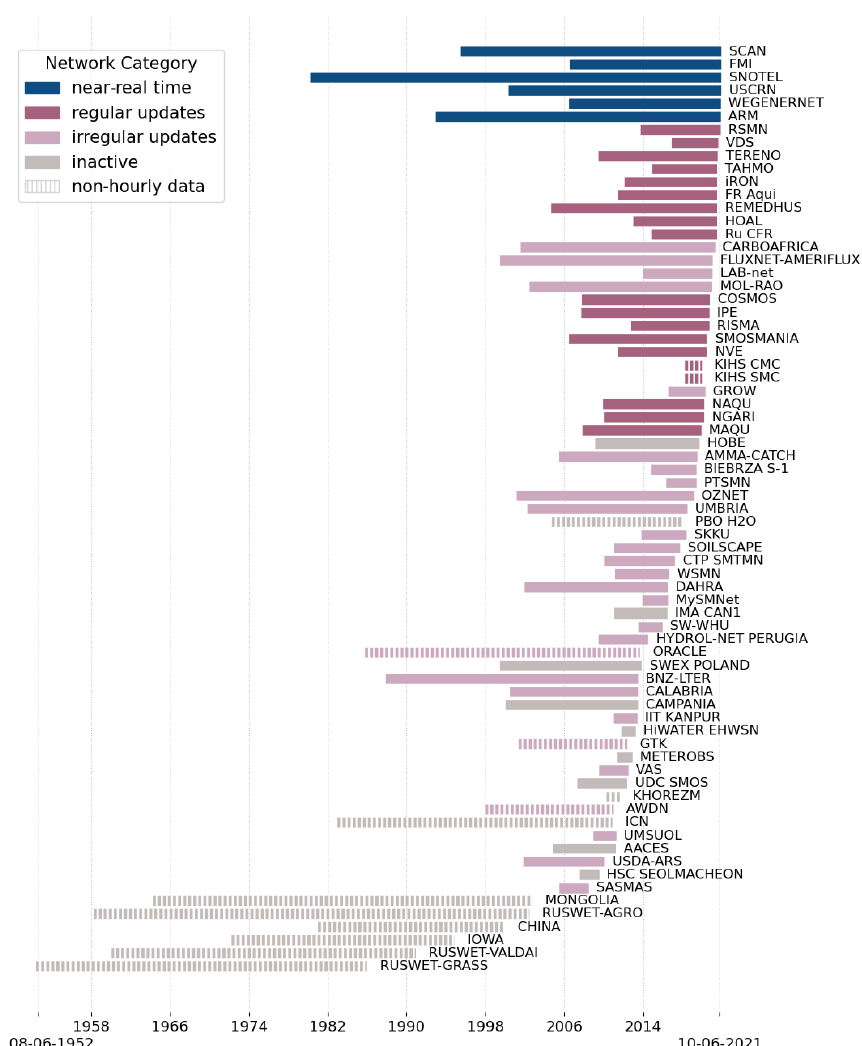
Figure 3. Overview of all available networks, the individual time span of the data availability within the ISMN, their operational status, and their updating frequency (status in June